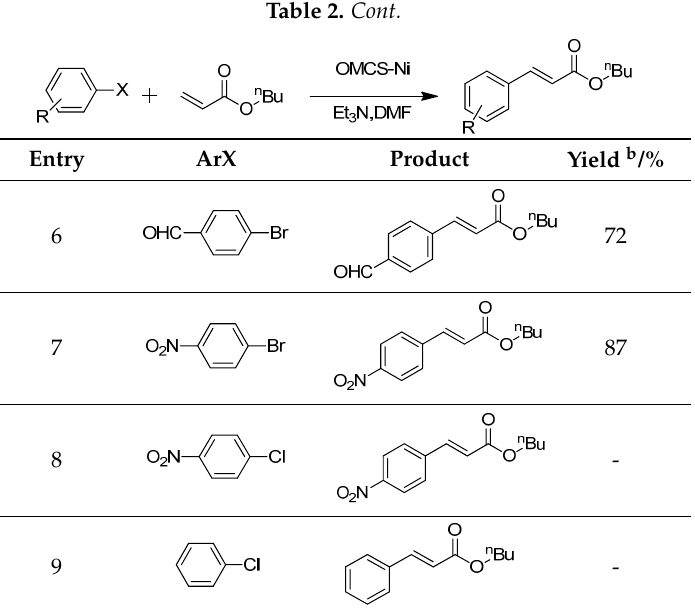
Table 2. Cont. Table 2. Heck reaction of aryl halides and n -butyl acrylate catalyzed by OCMCS-Ni a .